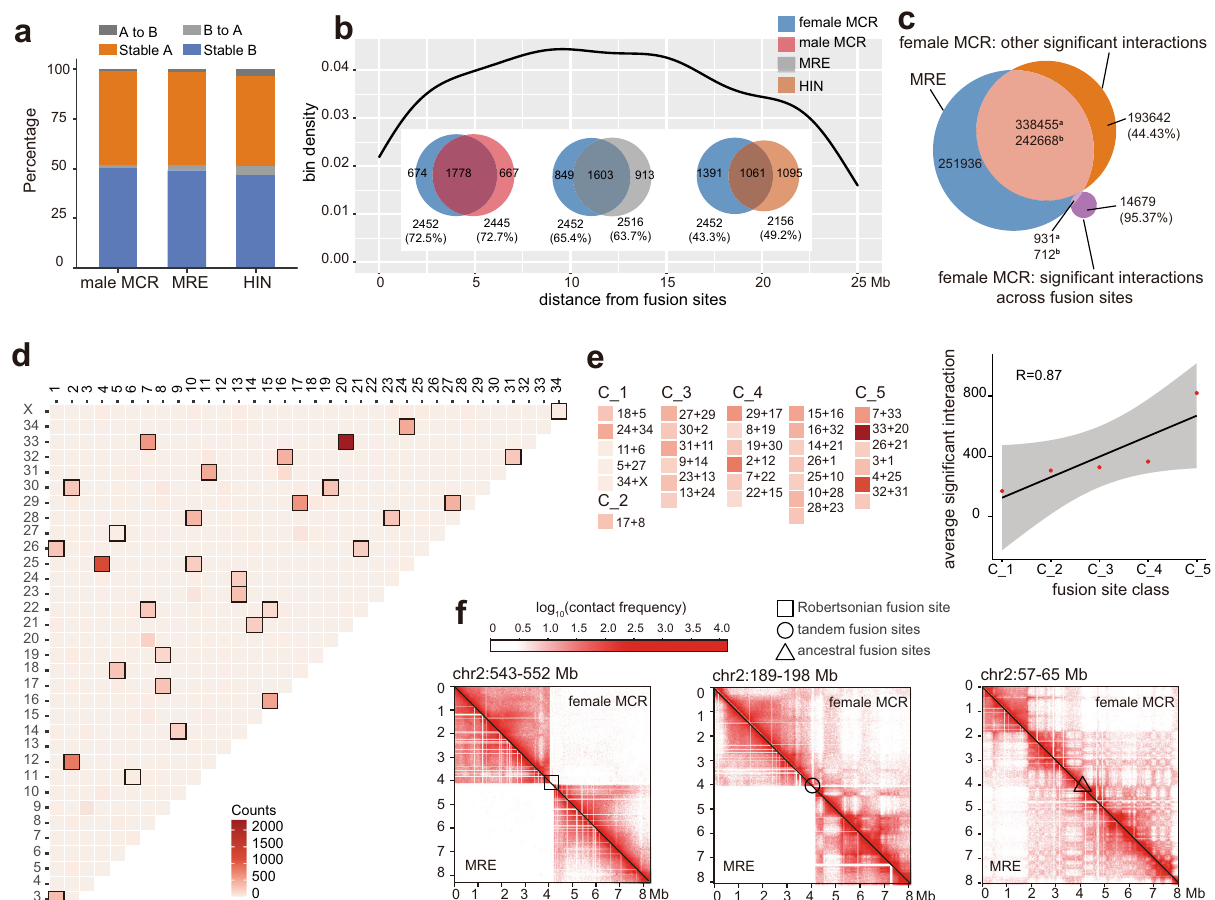
Fig. 2 Evolution of 3D chromatin architectures along with chromosome fusion in muntjacs. a Comparison of compartment A/B between female M. crinifrons and other three genomes. “ A to B ” means the homologous bins are compartment A in female M. crinifrons but compartment B in other genome. “ B to A ” is the opposite. “ stable A ” or “ stable B ” indicates the homologous bins in all genomes have the same compartment type. “ Other ” represents bins without exact compartment type. MCR, M. crinifrons ; MRE, M. reevesi ; HIN, H. inermis . b Comparison of TADs. Venn diagrams show the number and proportion of conserved or speci fi c TADs in female M. crinifrons compared with other three genomes. Density map shows density distribution of M. crinifrons -speci fi c TAD bins along fusion sites. c Number of shared and speci fi c signi fi cant interactions between M. reevesi and female M. crinifrons . Superscript “ a ” indicates signi fi cant interactions of M. reevesi shared by female M. crinifrons and superscript “ b ” indicates signi fi cant interactions of female M. crinifrons shared by M. reevesi . In parentheses are the percentage of signi fi cant interaction speci fi c to female M. crinifrons . d Heatmap of number of signi fi cant interaction across fusion sites in female M. crinifrons . The horizontal and vertical coordinates are ancestral chromosomes represented by chromosome coeds of H. inermis , on which the signi fi cant interaction anchored their two ends. The ancestral chromosome pairs adjacently fused in female M. crinifrons are framed by black boxes. e Number of signi fi cant interactions just across one fusion site extracted from Fig. 2d. and displayed according to ages of fusion site (C_1~C_5). The average number of signi fi cant interactions were fi tted linearly with the age stage of fusion site using Pearson method. f Combined heatmaps of contact matrix around the fusion sites of female M. crinifrons (upper right) and their homologous regions in M. reevesi (lower left) at 20 kb resolution. Hollow shapes mark the locations of fusion sites. Different geometries represent different fusion site types. The “ ancestral fusion sites ” are the oldest tandem fusion sites. The “ tandem fusion sites ” represent the rest tandem fusion sites. The “ Robertsonian fusion sites ” refers to the youngest fusion sites raised by Robertsonian